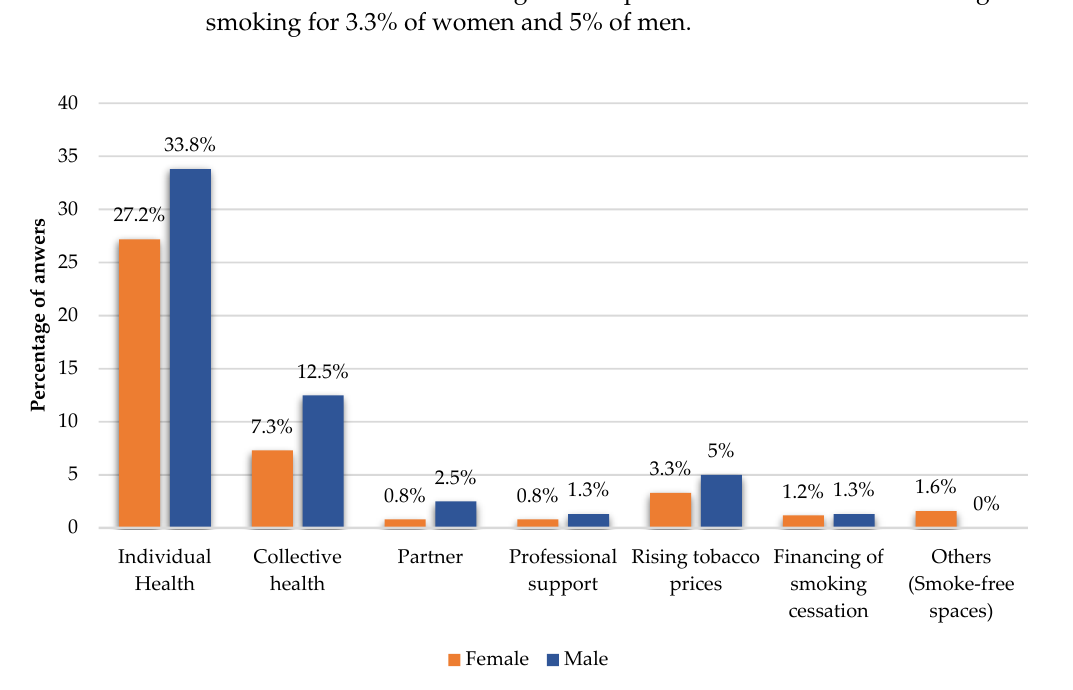
Figure 4. Sources of motivation to quit smoking.